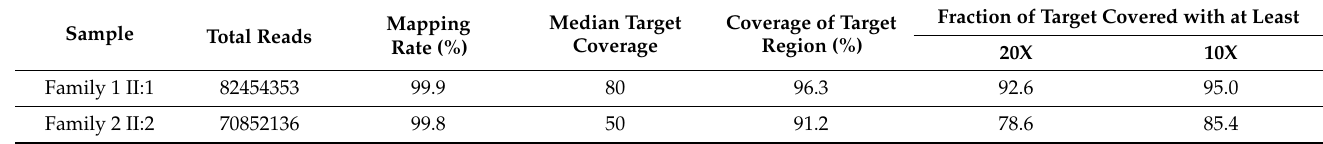
Table 1. Statistics for exome